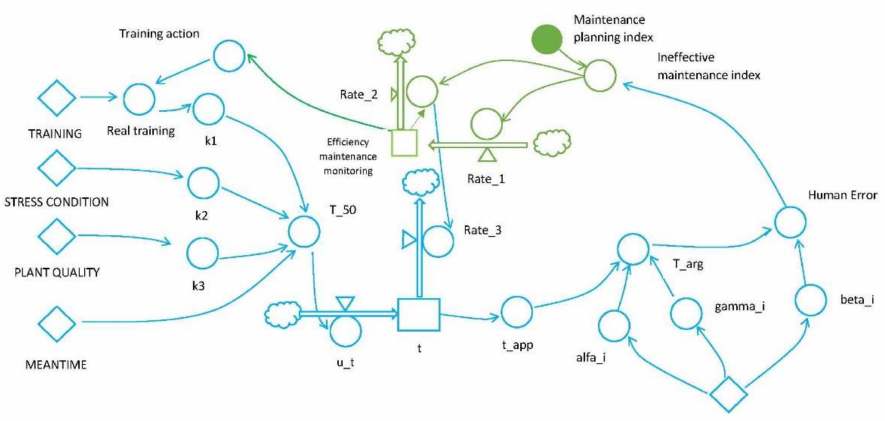
Figure 7. System dynamics diagram—HCR and maintenance variables.